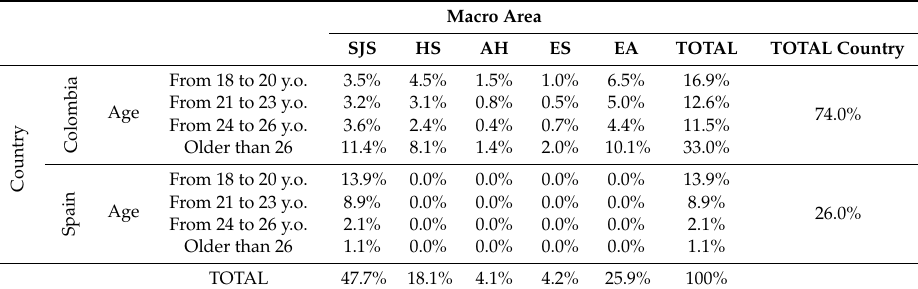
Table 1. Profile of the students as a function of the macro area, age and